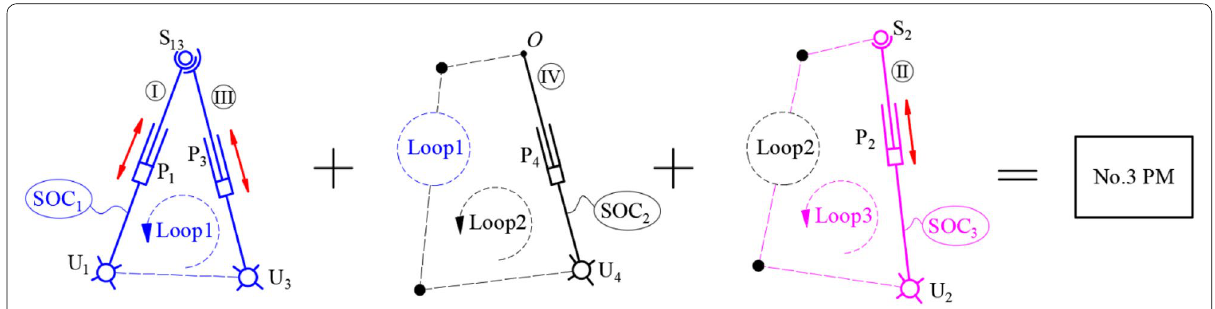
Figure 6 Topological decomposition of No. 3 PM